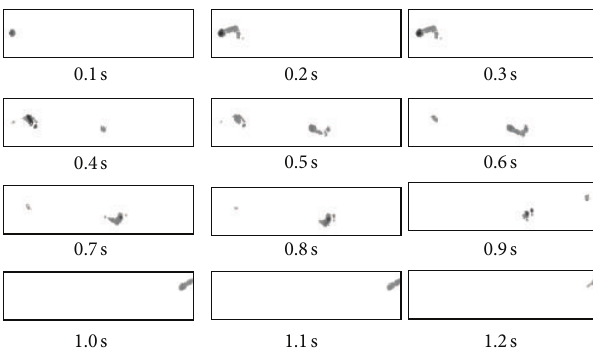
Figure 4: Examples of load distribution while walking.